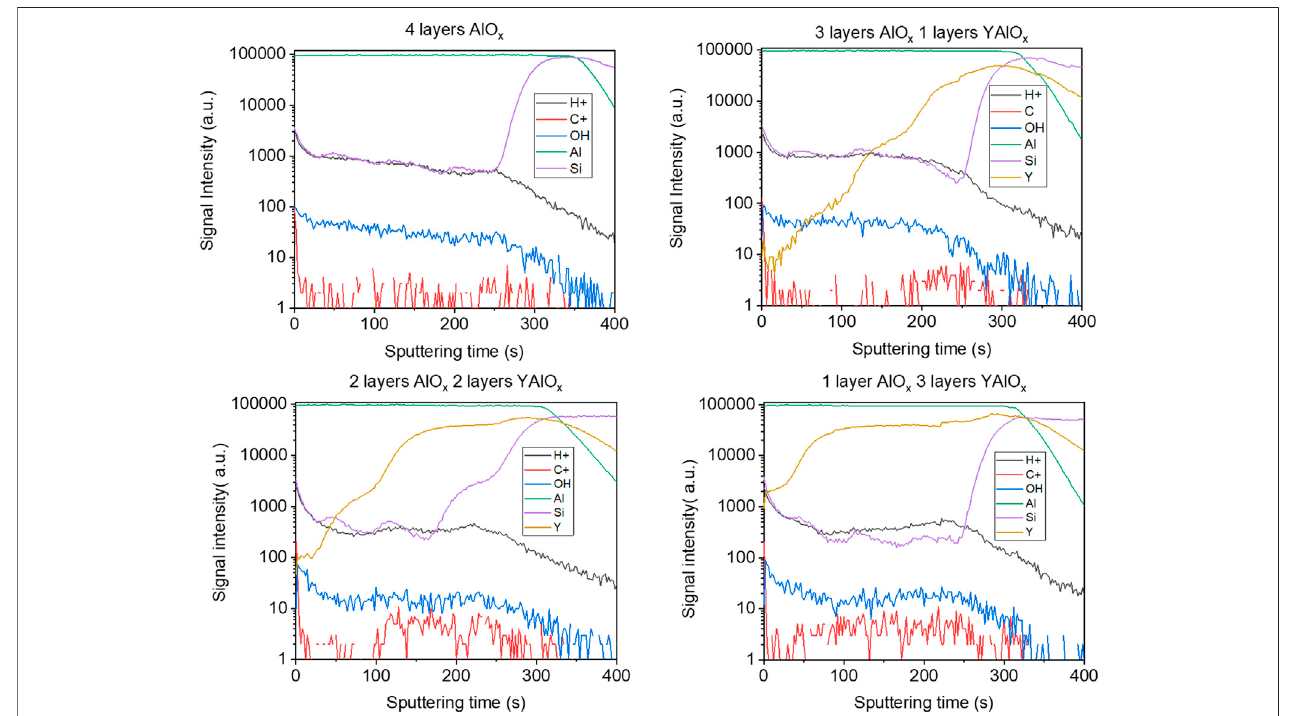
FIGURE 5 | SIMS pro fi le shows residuals ’ behaviors (H + , OH − , and C) across the AlO x /YAlO x layer stacks.